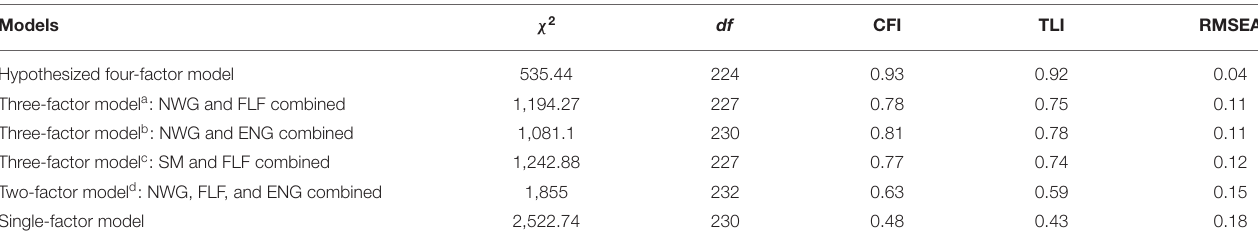
TABLE 2 | Model fit results for confirmatory factor analyses. Models Hypothesized four-factor